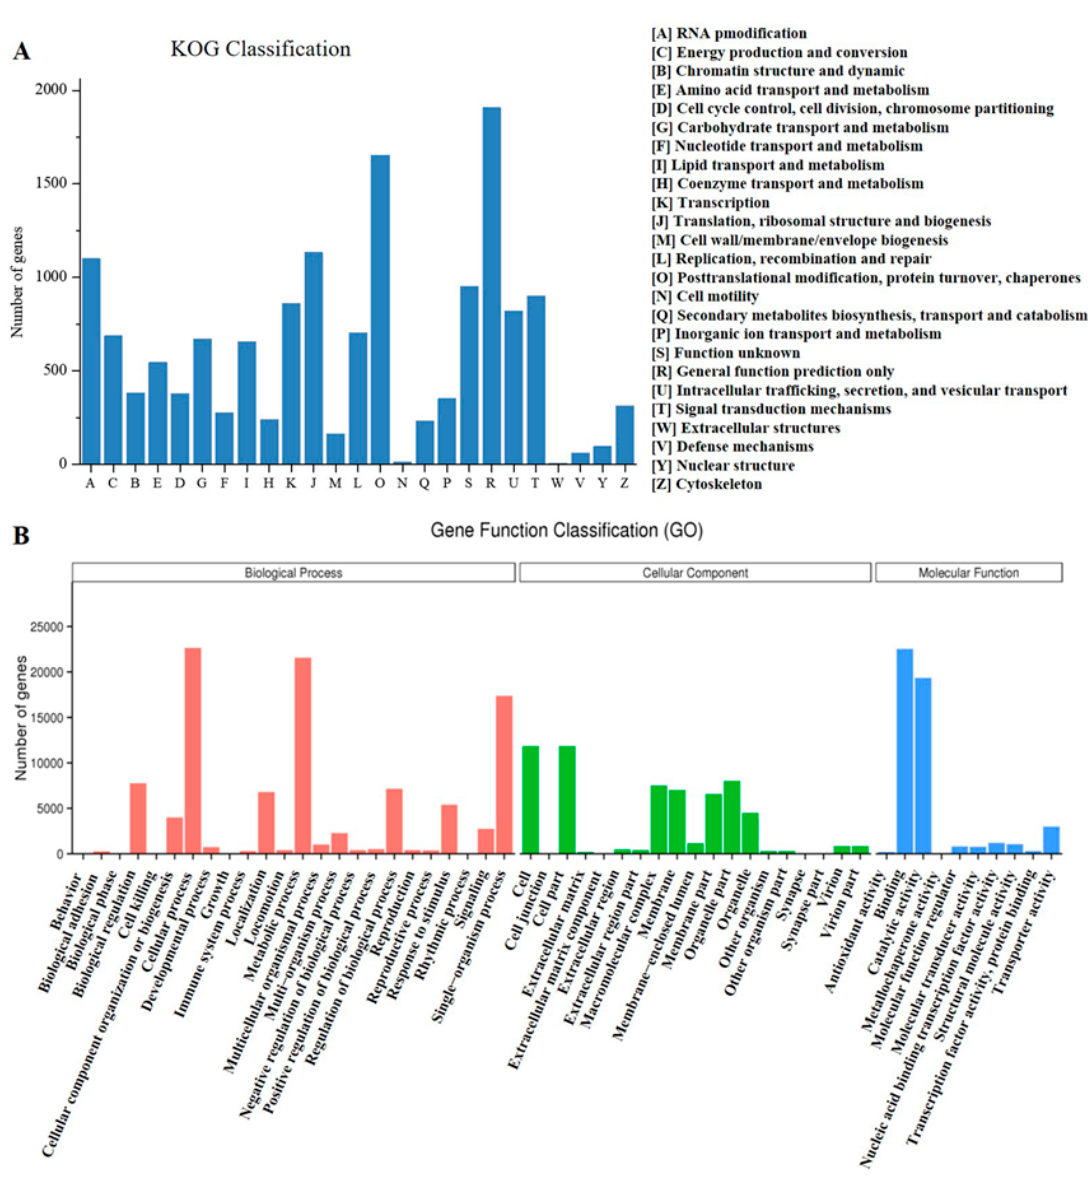
Figure 2. Classification of the function of the E. tirucalli unigenes based on the KOG ( A ) and GO ( B ) analysis.